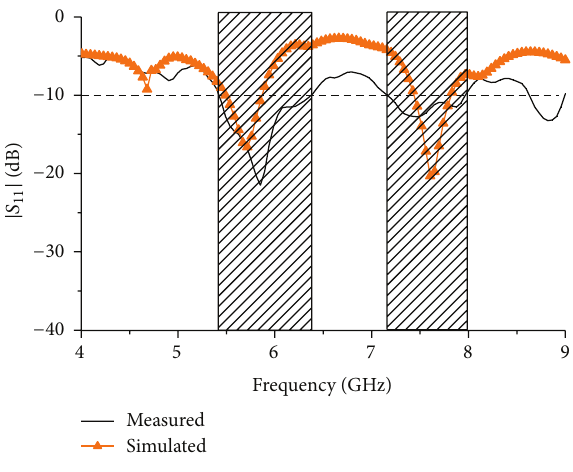
Figure 8: 𝑆 11 response of the